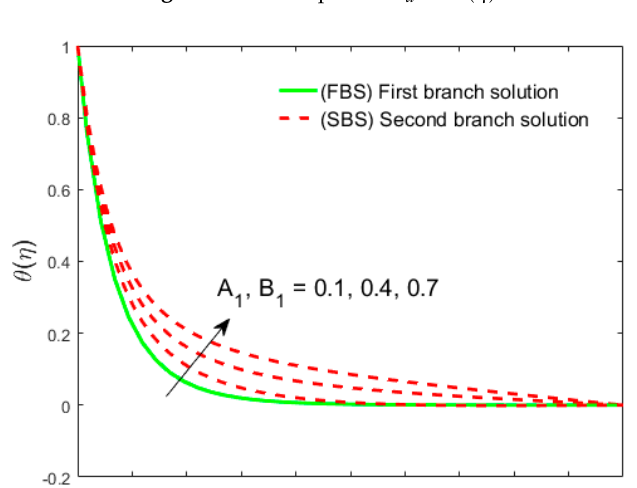
Mathematics 2020 , 8 , x FOR PEER REVIEW 20 of 29